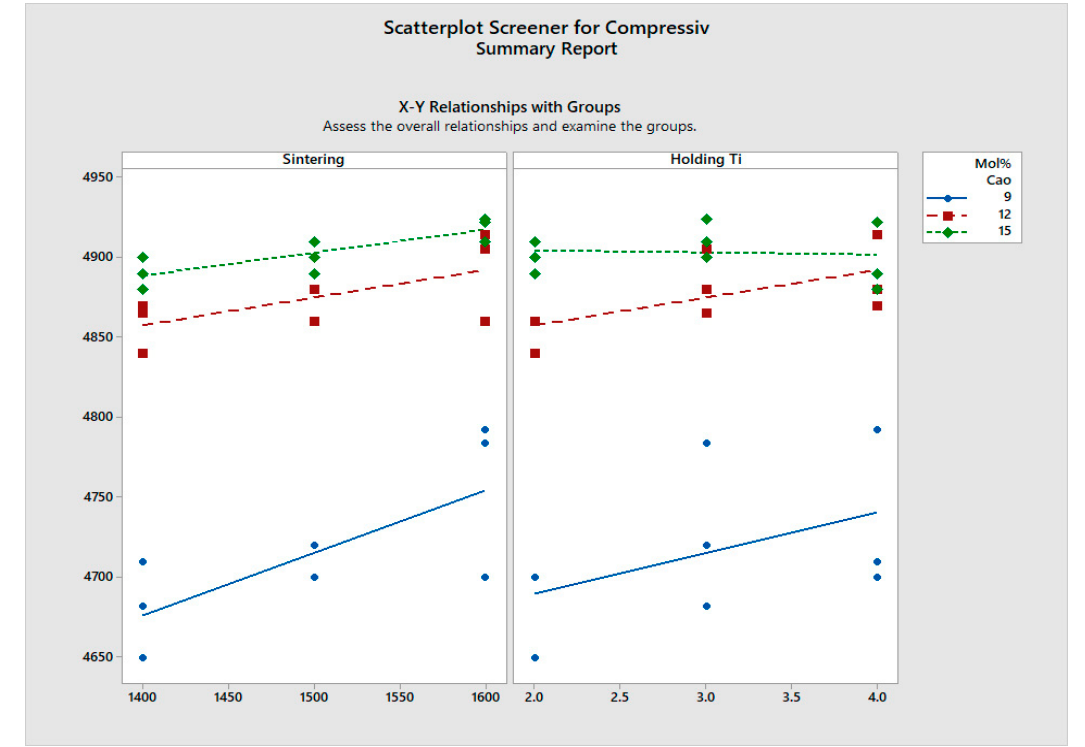
Figure 9. Effect of composition, sintering temperature, and holding time on compressive strength.